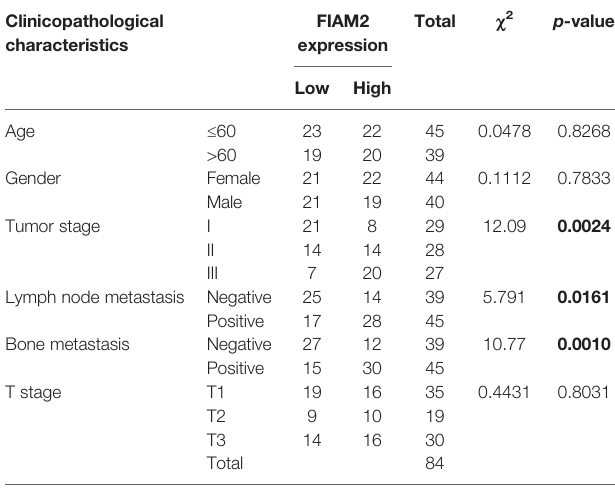
TABLE 2 | Correlation between FAIM2 expression and multiple clinicopathological characteristics in NSCLC patients. Clinicopathological